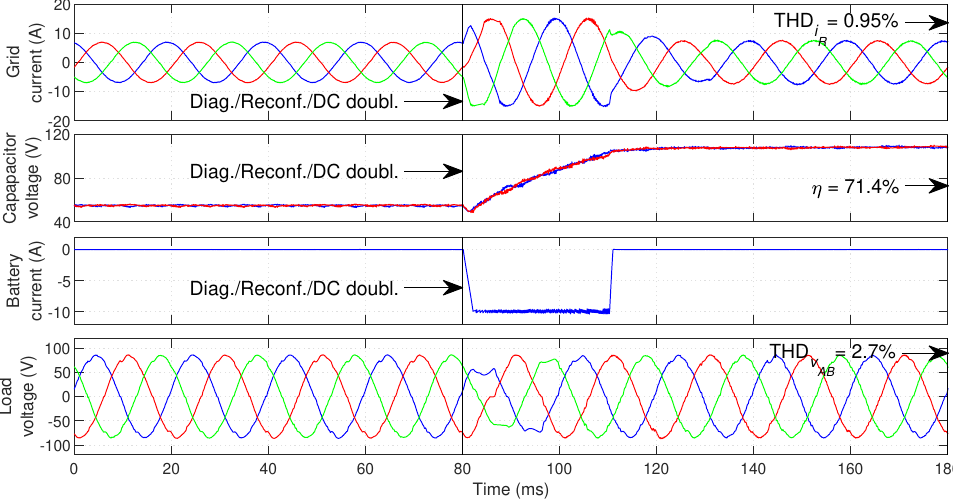
Figure 21. Normal and fault-tolerant UPS operation when an OC occurs in inner IGBT S A 2 of the LSC. The fault occurs at t = 80 ms and is quickly identified. The DC bus voltage reference is immediately doubled and the controller avoids the affected switching states. The GSC and DCC immediately begin to inject as much power as possible into the DC bus, raising its voltage to the new reference value (220 V) in little over 30 ms. The grid-current distortion remains close to the pre-fault values. The load voltage distortion after the reconfiguration is not significantly increased (raises from 2.55% to 2.7%). During the transient, the load voltage is distorted (mainly in phase A ). However, this distortion is relatively mild and lasts only for about one fundamental period, which should not compromise the critical load operation. The DC bus capacitors balance is not significantly affected by LSC faults, since the GSC is the main responsible for maintaining the DC bus capacitors